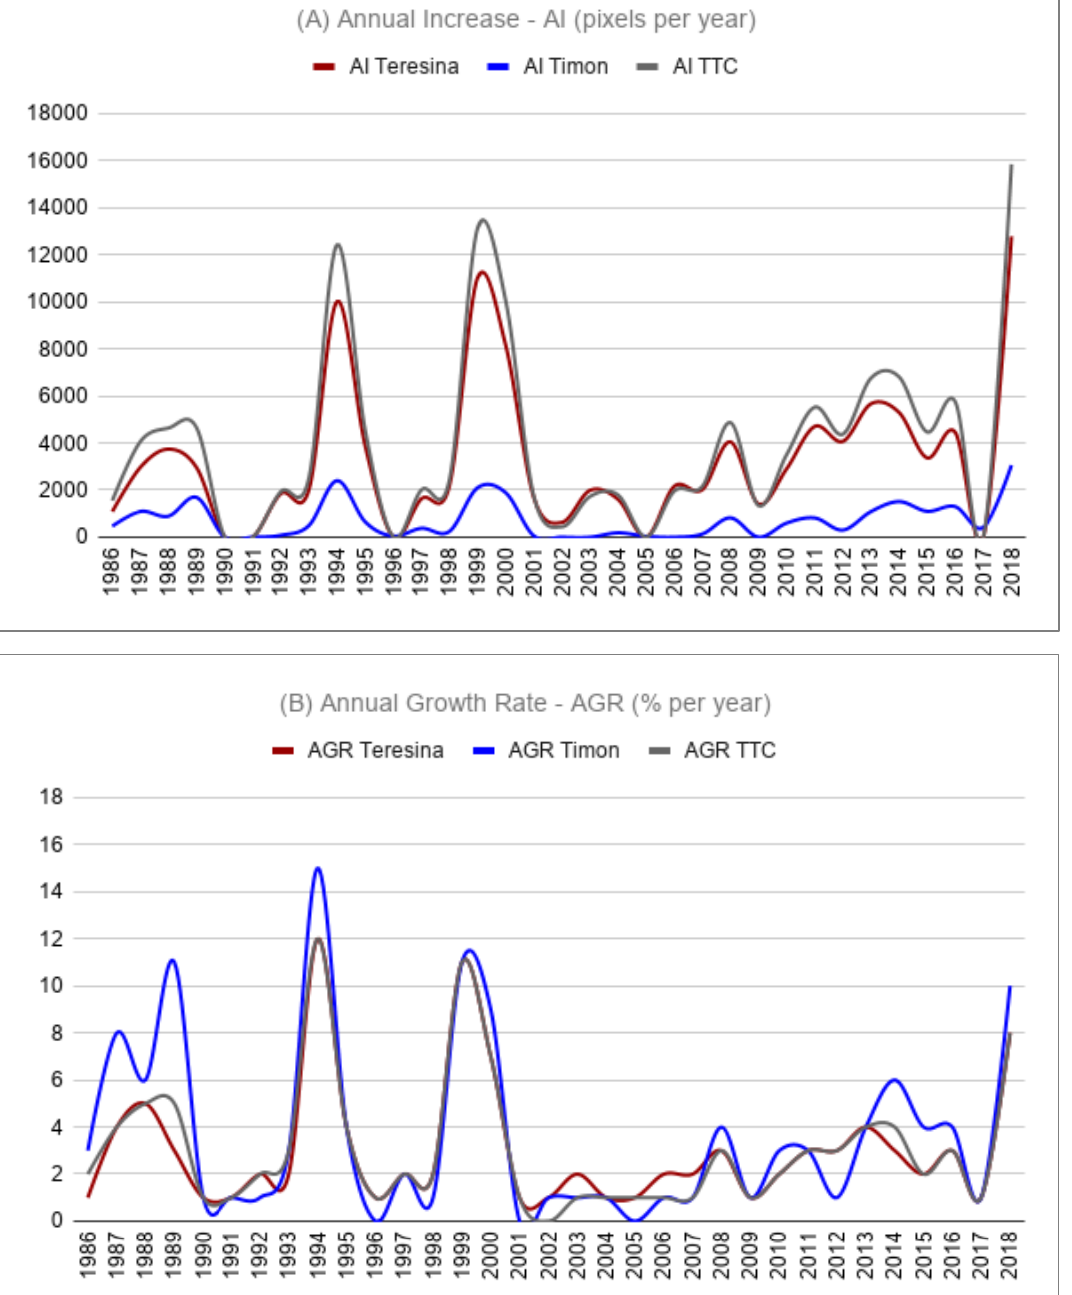
3.69% Figure 7. ( A ) Annual increase (AI) (in pixels) for each year from 1985 to 2018 for: TTC area (grey); Teresina (red); and Timon (blue). ( B ) Normalized annual urban growth rate (AGR) (%) for each year from 1985 to 2018 for: TTC area (grey); Teresina (red); and Timon (blue). ( C ) AI and AGR computed for decades: 1985 — 1995, 1995 — 2005, 2005 — 2015, and the average for 1985 — 2018 period. 3.2. Characterization of the Urban Fabric In Figure 8, we illustrate the 2019 LULC classification generated from the Sentinel-2 dataset. For this result, we got an OA and KC of 0.94 and 0.91, respectively. To characterize the urban fabric (UF) in the TTC area, we present the proportion of the LULC classes di- rectly associated with intra-urban characteristics: Residential — Ceramic roofs, Residen- tial — Other roofs, and Impervious surfaces. In the TTC area, 28.02% of the urban land was covered by ceramic roof tiles, and 11.97% by other roofs, including roofs of concrete, me- tallic, or asbestos. Usually, red ceramic roof tiles are associated with households, and our results show a predominance of this material with a high built-up density across Teresina (30.84%) and Timon (21.38%). On the other hand, other types of roofs are also frequent, and in this area, they are mostly associated with commercial buildings or apartments. This coverage shows a considerable difference among Teresina (15.42%) and Timon (3.85%). Indeed, part of the recent urban development of Teresina was based on vertical growth, especially in its high-income district. In the literature, impervious surface cover is usually used as an indicator of the built- up urban land density [44]. We defined impervious surfaces as the surfaces that water